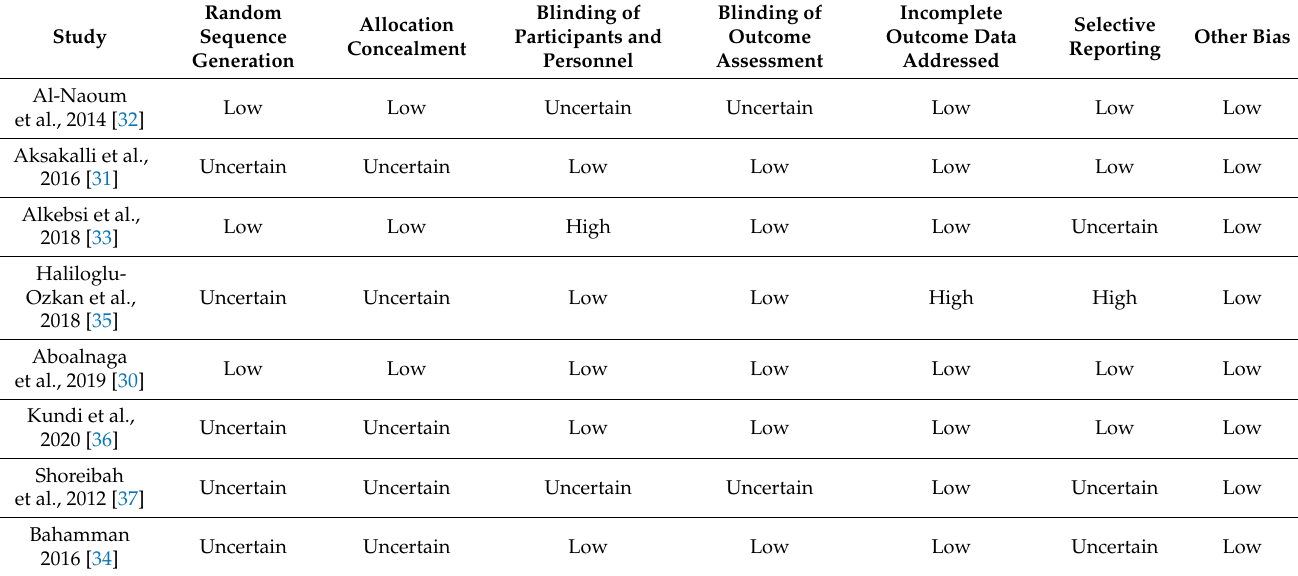
Table A1. Risk assessment of publication bias for the included RCTs.